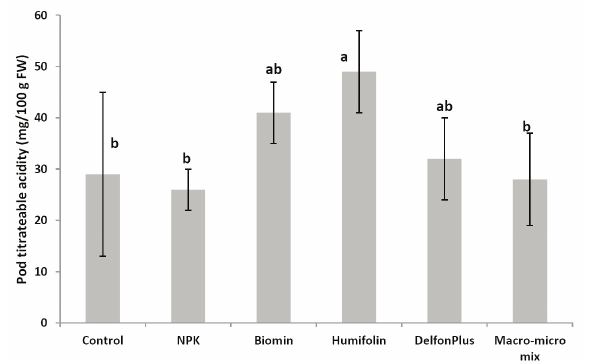
Fig. 1 - Effects of various fertilization treatments on titratable acidity of French bean pods. Data are mean of four repli- cates ± SD. Comparison of means was done using Duncan’s test at 5% level.